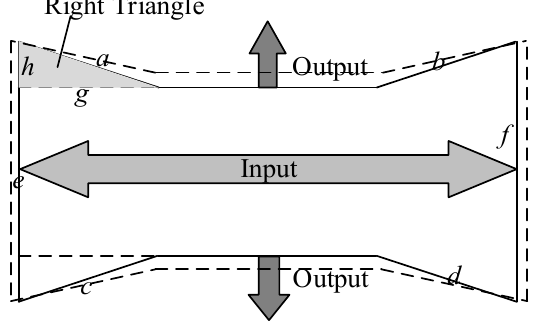
Figure 2. Simplified diagram of a bow-type amplifier.